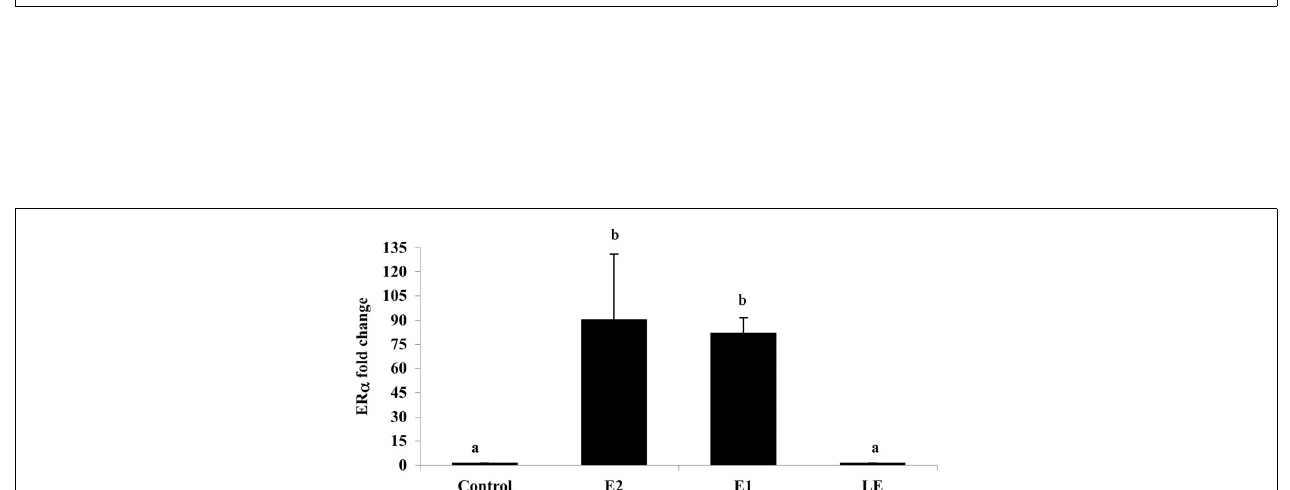
FIGUREA4 | High-pressure liquid chromatography chromatograms of estrone solutions (10 μ M) in untreated sewage water) irradiated by UV-B (135 μ Wcm − 2 ; Helios Italquarz) for different times. (A) t = 0, (B) t = 1min, (C) t = 4min, and (D) t = 10min. HPLC analysis under isocratic